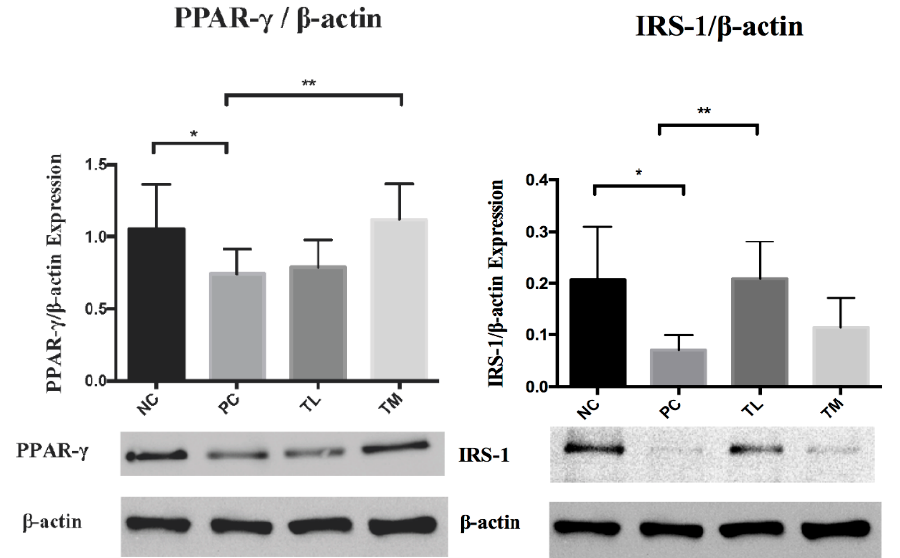
Figure 5. Effect of IMD on PPAR- γ and IRS-1expression in white adipose tissue of mice as determined by Western blot. Results are expressed as mean ± SEM for n = 4 samples per group. Differences in means were considered statistically significant for * p < 0.05 or ** p < 0.01.